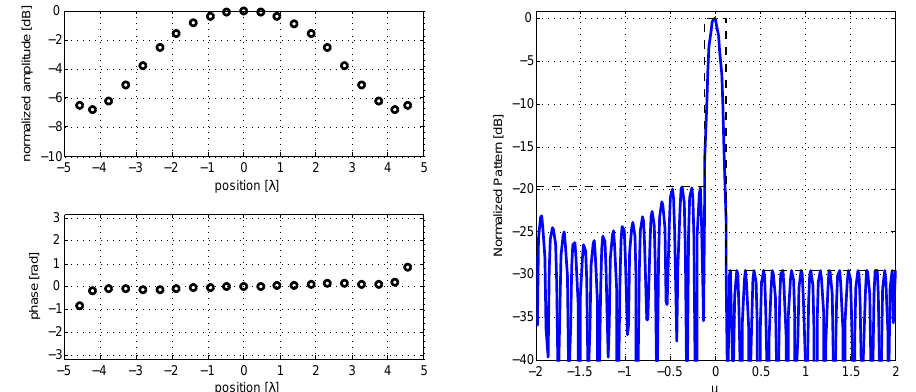
Figure 2. The achieved 21 element asymmetric pencil beam layout. On the left : normalized amplitude and excitation phase; on the right : pencil beam pattern with its upper